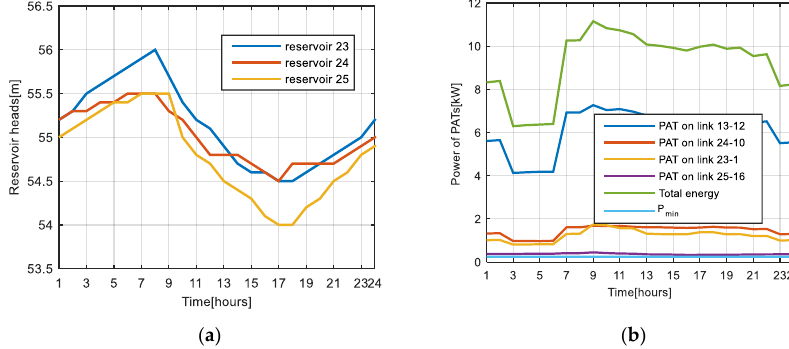
Figure 2. Reservoir water levels for 24 h ( a ) and powers of PATs ( b ) for scenario 1.